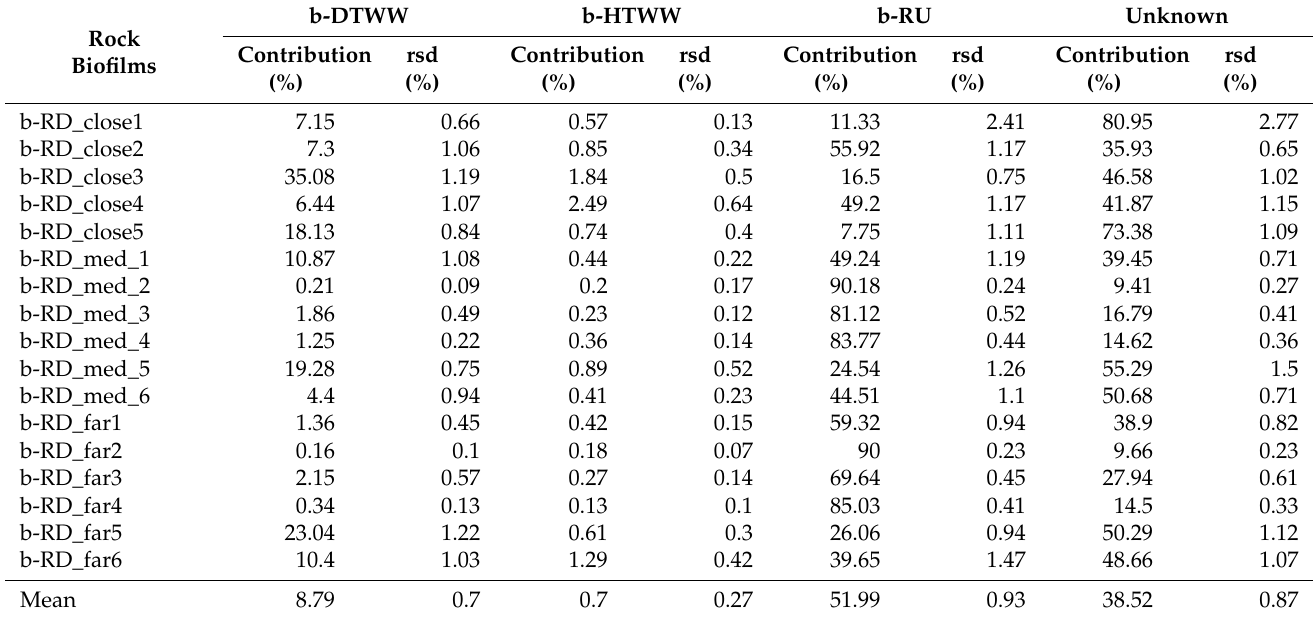
Table 1. Relative contributions of tpm -harboring bacterial ASV from b-HTWW (biofilms developing from hospital sewer treated wastewaters), b-DTWW (biofilms developing from domestic sewer treated wastewaters), and biofilm river taxa upstream (b-RU) the SIPIBEL WWTP outlet, in the build-up of downstream river biofilms (b-RD) as computed by a SourceTracker Bayesian analysis using datasets of Table S3. See Table S1 for a full description of the